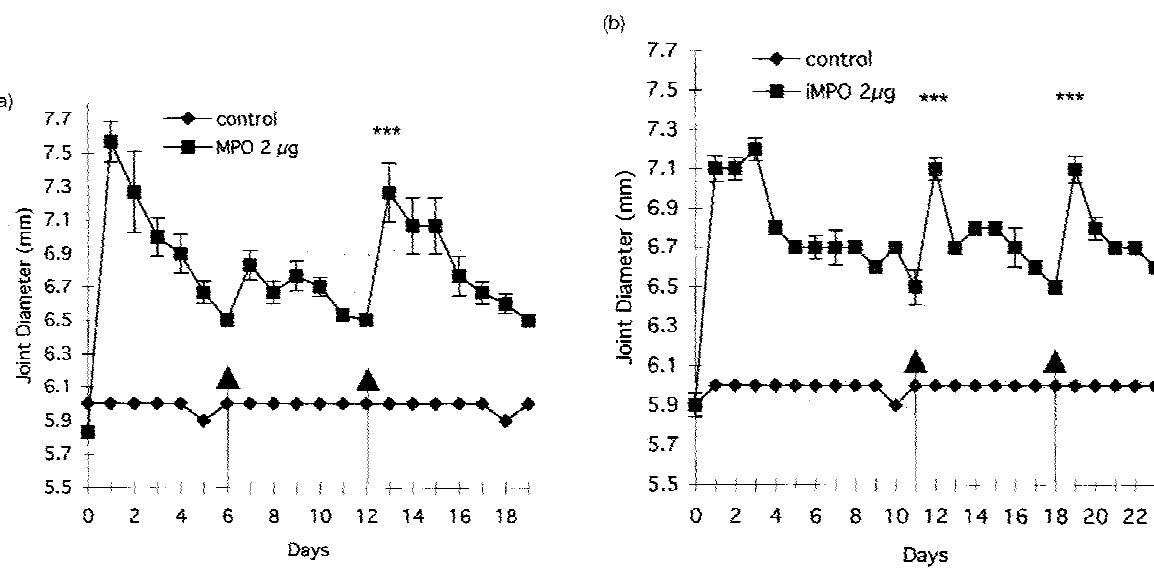
FIG. 2. (a) Exacerbation of peri-articular swelling after re-injection of pre-treated joints with enzymatically active myeloperoxidase (MPO). On day 0, animals were injected with 10 m l PG-APS (2 m g of rhamnose/joint) in the left ankle joint and 10 m l normal saline in the right ankle joint. After the treated joint returned to ‘baseline’ level of swelling/erythema, the exacerbation regimen was started. On days 6 and 12 (as depicted by the arrows), animals were re-injected with 10 m l MPO (left ankle joint) and 10 m l normal saline (right ankle joint). These values represent the results of at least 3–5 animals. The experiment was repeated at least once. *** P £ 0.001. (b) Periarticular swelling after re-injection of PG-APS pre-treated joints with enzymatically inactive myeloperoxidase (iMPO). On day 0, animals were injected with 10 m l PG-APS (2 m g of rhamnose/ joint) in the left ankle joint and 10 m l normal saline in the right ankle joint. After the treated joint returned to ‘baseline’, the exacerbation regimen was started. On days 11 and 18 (as depicted by the arrows), animals were re-injected with 10 m l iMPO (2 m g/joint): left ankle joint and 10 m l normal saline (right ankle joint). Graphed values represent the results of 3–5 animals. The experiment was repeated at least once. The concentrations reflected in the graph are those present in the joint. *** P £